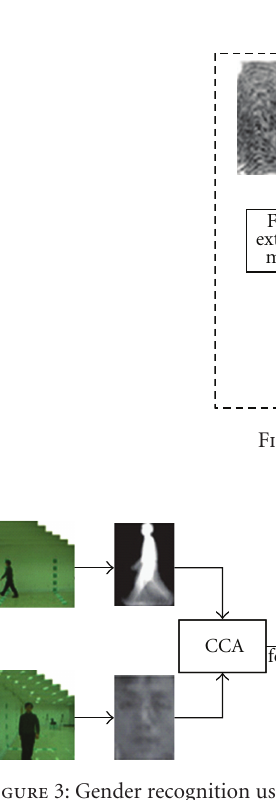
Figure 1: Example of discrete soft biometric traits.